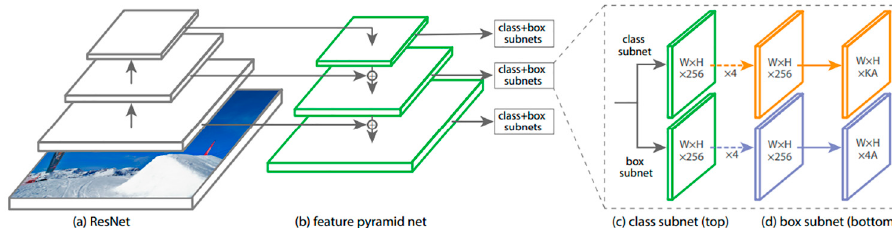
Figure 2. The RetinaNet architecture uses a Feature Pyramid Network [21] backbone on top of a feedforward ResNet architecture [22] ( a ) to generate a rich, multi-scale convolutional feature pyramid ( b ). To this backbone RetinaNet attaches two subnetworks: one for classifying anchor boxes ( c ) and one for regressing from anchor boxes to ground-truth object boxes ( d ). (Reprinted and adapted with permission from ICCV 2017 [20].)